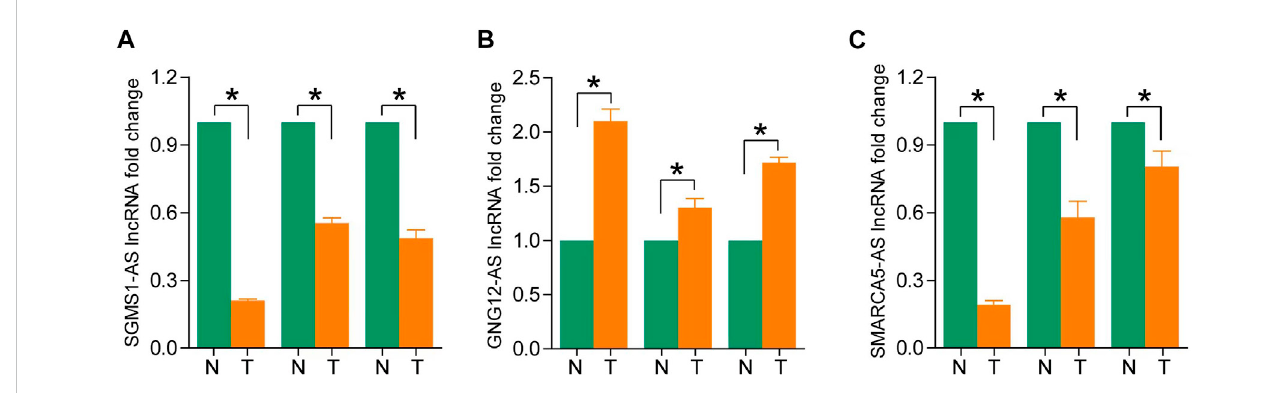
FIGURE 8 (A – C) ExpressionlevelsofSGMS1-AS1,GNG12-AS1,andSMARCA5-AS1inccRCCparaneoplastictissuesandccRCCsamplesbyRT-PCR(* p < 0.05,** p < 0.01, *** p <